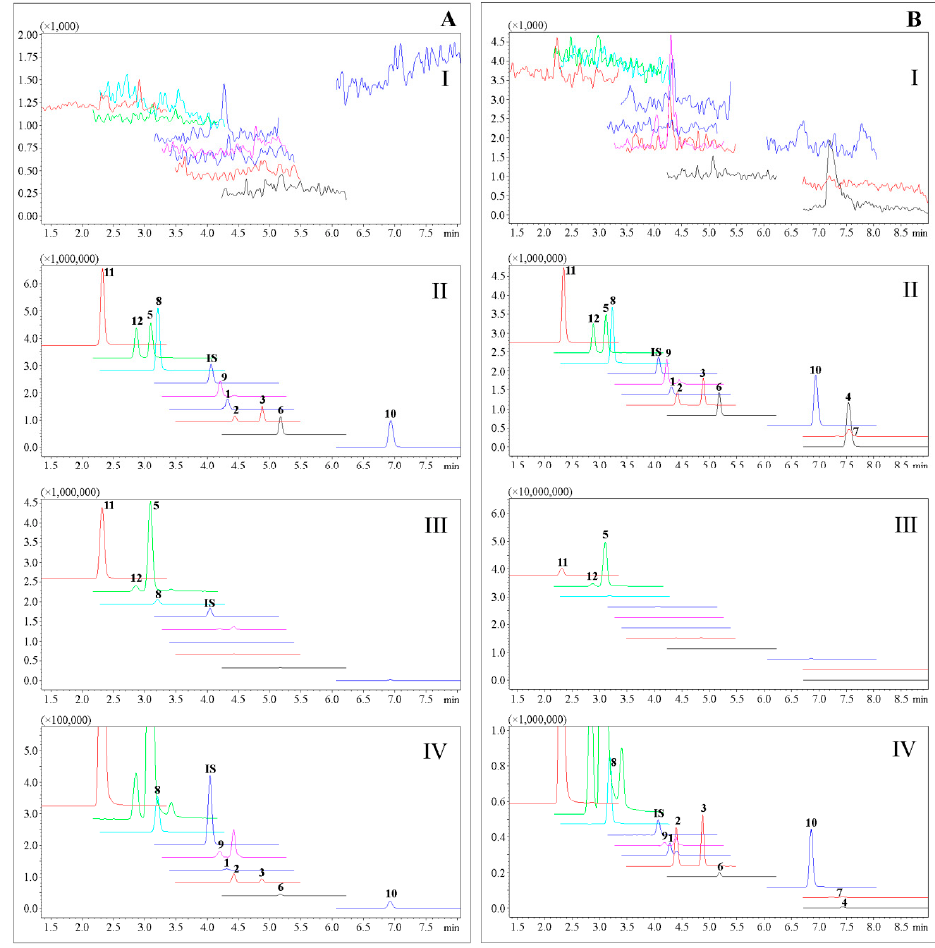
Figure 2. Multiple reaction monitoring (MRM) results of the analytes 1 – 12 and IS. ( A ) CSF samples: (I) blank CSF; (II) blank CSF spiked with analytes and IS of 20 ng/mL; (III) CSF sample at 2 h after oral administration of APR extract (APRE); (IV) enlarged view of III. ( B ) Brain samples: (I) blank brain; (II) blank brain spiked with analytes and IS of 20 ng/mL; (III) brain sample at 2 h after oral administration of APRE; (IV) enlarged view of III. Table 1. The MW, precursor ion, product ion, quadrupole 1 pre-rod bias (Q1), quadrupole 3 pre-rod bias (Q3), collision energy (CE), dwell time (DT) and retention time (RT) of twelve coumarins and IS.